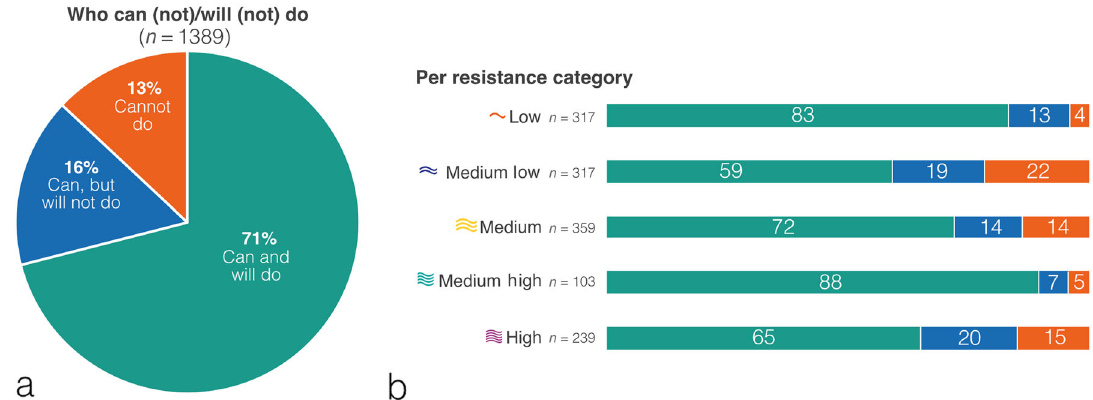
Fig. 6 Overview of participants. Participants who can (not)/will (not) reach optimal PIF ( a ), and percentage of participants who can (not)/will (not) do per inhaler resistance category ( b ). Peak Inspiratory Flow categories based on In-Check DIAL G-16, by internal device resistance